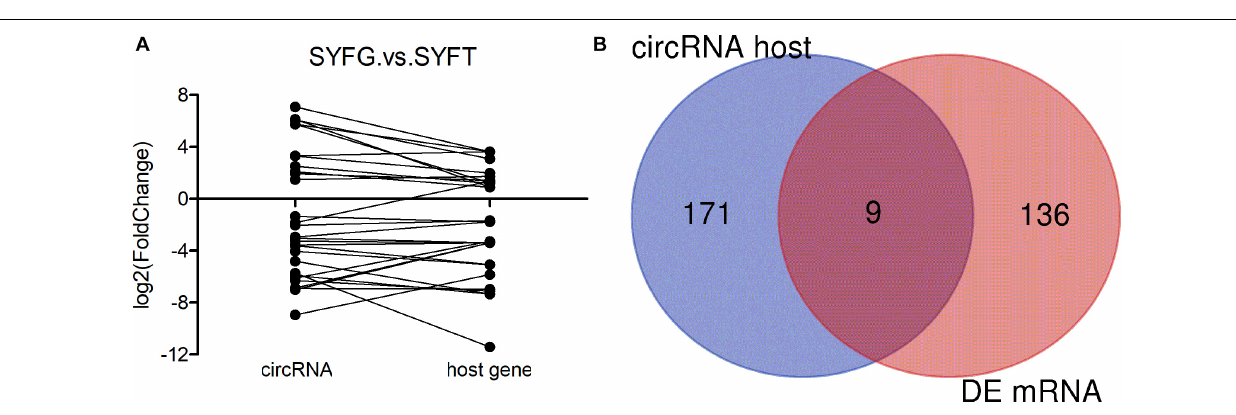
FIGURE 3 | Expression level of relationship between circRNA and its host genes. (A) Fold change of circRNA and its host genes; (B) Venn diagram of DE circRNA host genes and DE mRNA in SYFG vs. SYFT comparison group. SYFG, granulosa cells of small yellow follicle; SYFT, theca cells of small yellow